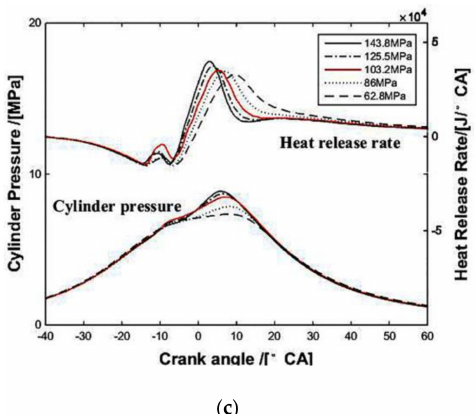
Figure 3. Effects of different injection parameters on the combustion process. ( a ) Different pre-injection timings; ( b ) Different main-injection timings; ( c ) Different injection